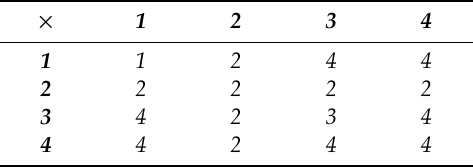
Table 16. The operation × on